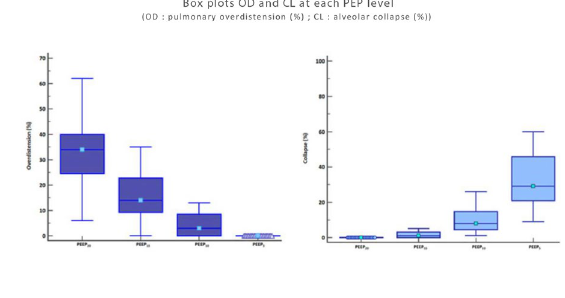
(Table 1). Conclusion : P0.1, Evita provides a reasonable estimate of P0.1 meas- ured near to the